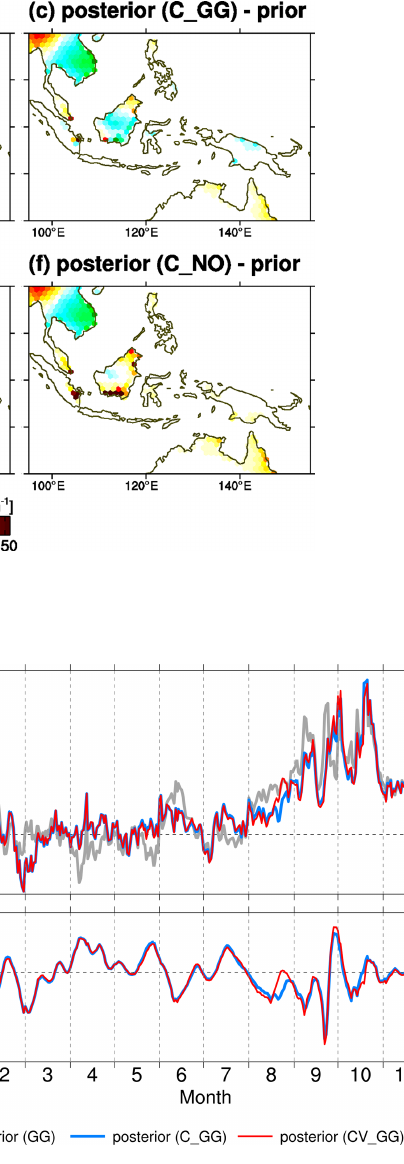
Figure 10. Time series of posterior total net carbon fluxes (a) and their differences from prior ( (cid:49) ) (b) for 2015. Posterior fluxes of C_GG (blue) and CV_GG (red) and their prior flux (grey) are pre-